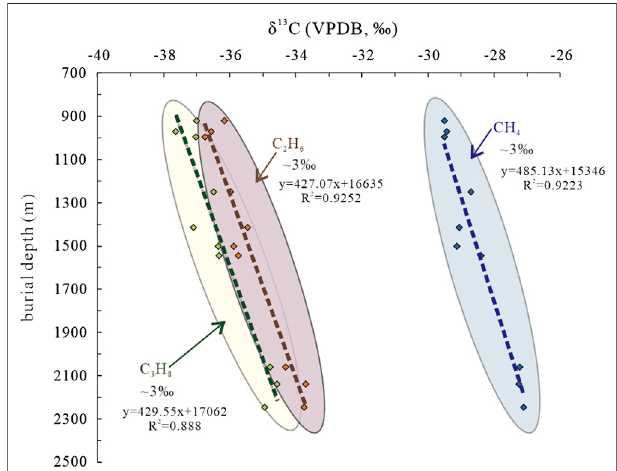
FIGURE 11 | Plot of δ 13 C values of methane, ethane, and propane versus burial depth of gases from the Taiyang, shale gas fi eld in the Sichuan Basin,